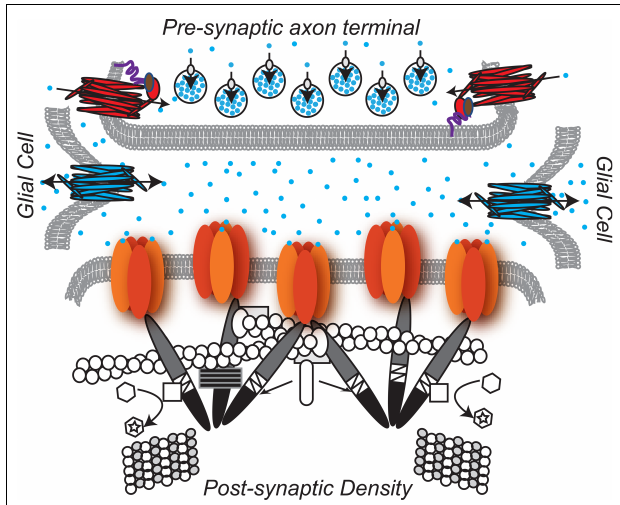
FIGURE 1 | The glycinergic synapse. Pre-Synaptic: Glycine is the predominant inhibitory neurotransmitter in the spinal